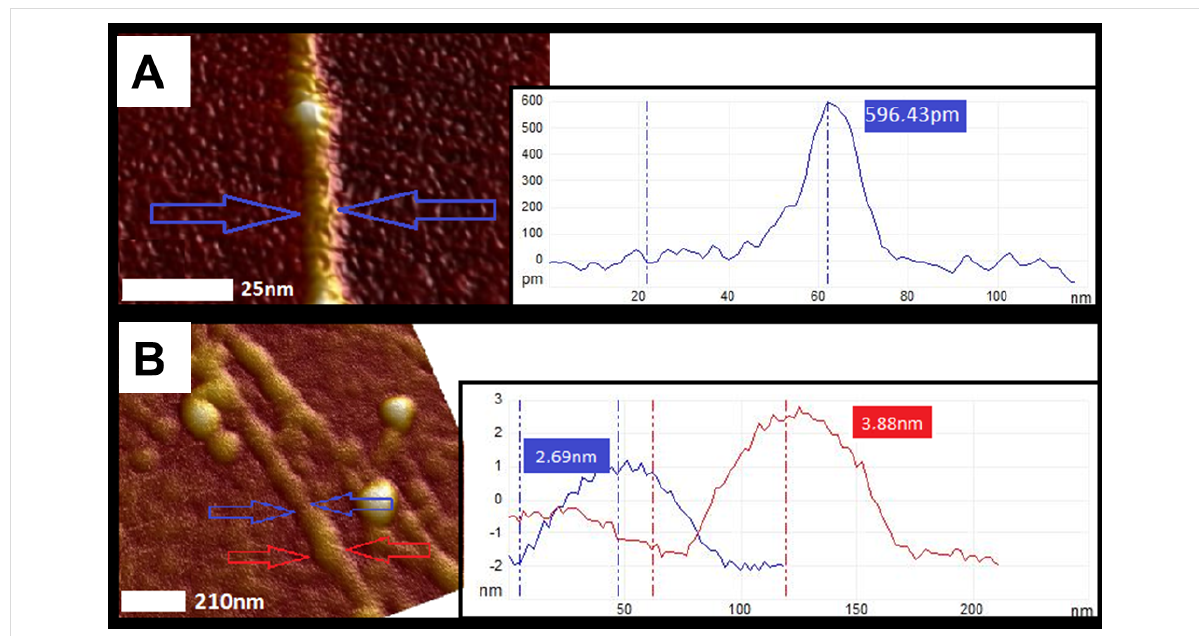
Figure 12: Diameter of nanotubes as measurements of height (AFM cross section analysis): (A) the diameter of a single (cholate dispersed) nano- tube is about 0.6 nm; (B) the diameter of CR covered SWNTs ranges from 2.7 to approx. 4 nm at the sites of weak